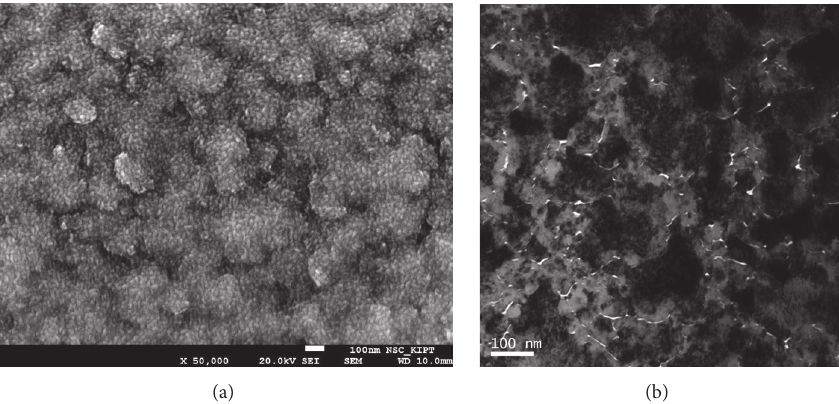
Figure 3: The structure of the surface (a) and particles and interparticle boundaries (b) of already formed VN 𝑥